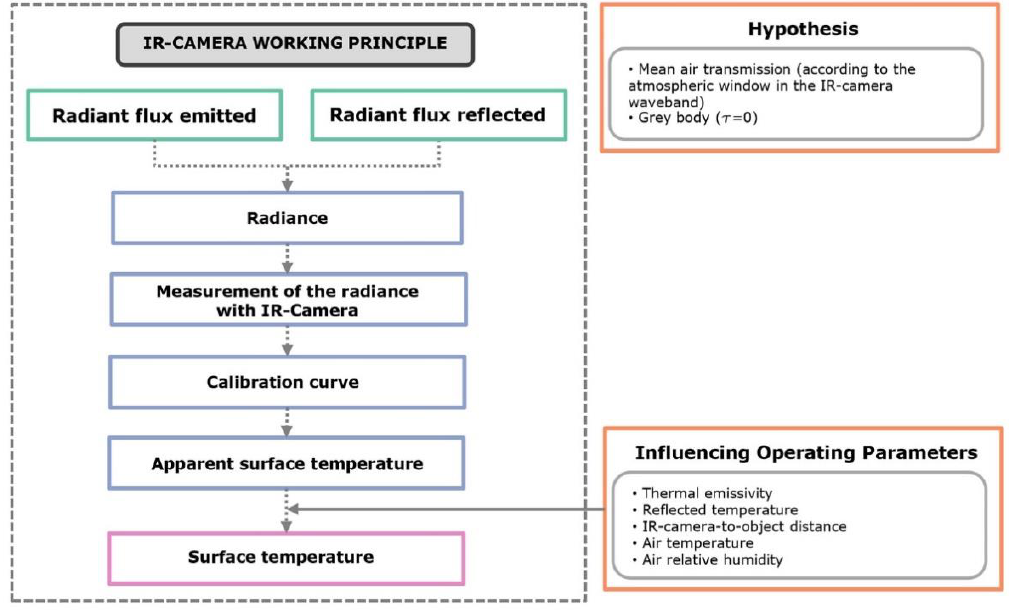
Figure 1. Basic principle of a thermal camera.